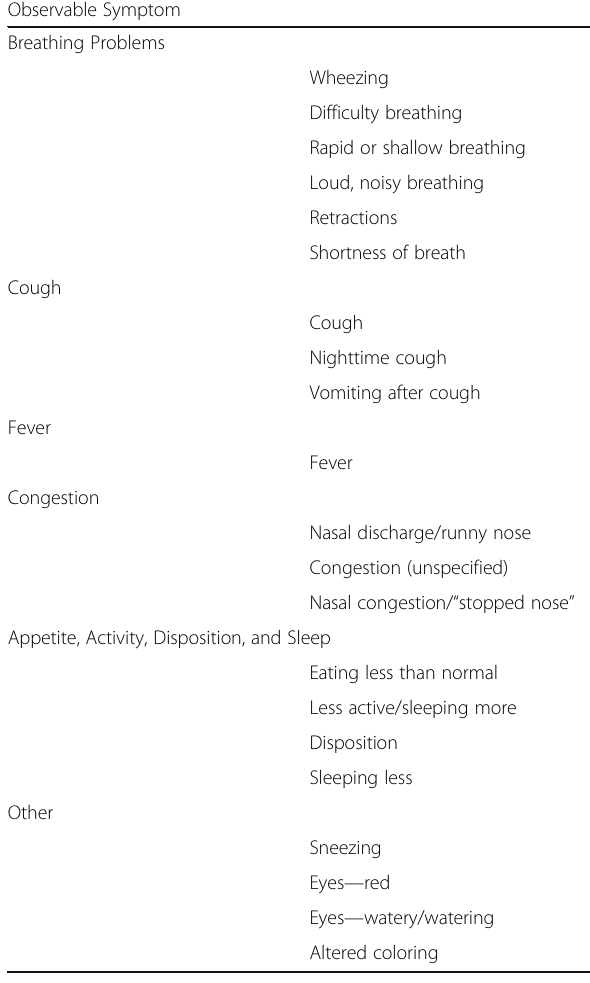
Table 3 Concepts Elicited From Interview Participants